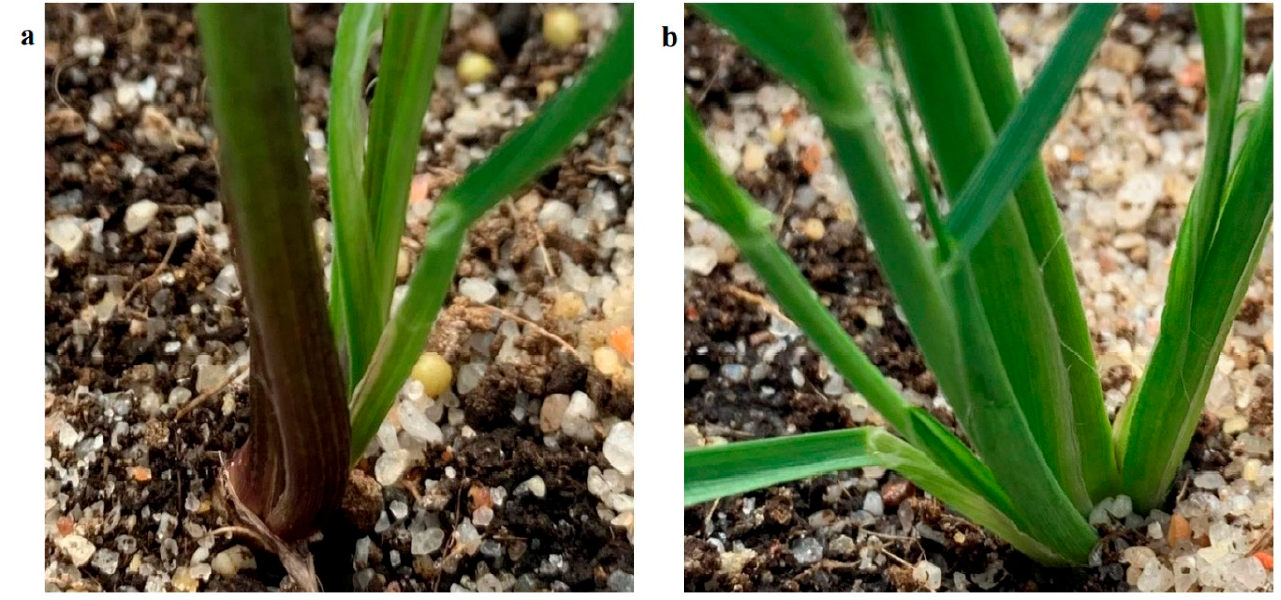
Figure 5. Healthy Aurora ( a ) and bread wheat ( b ). Shows that the lower stem and leaf sheath of healthy Aurora is brown and purple, while the bread wheat has a normal green color lower stem and leaf sheath.